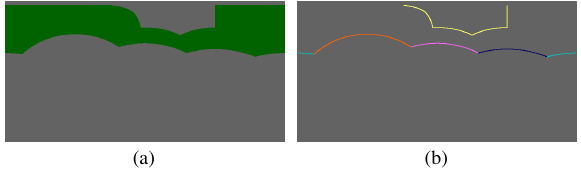
Figure 3. Segmentation of the { ϕ, θ } image represented Figure 5. Outline detection in a planar primitive. (a) Planar Figure 1(b) primitive extracted from { ϕ, θ } image, (b) labeled